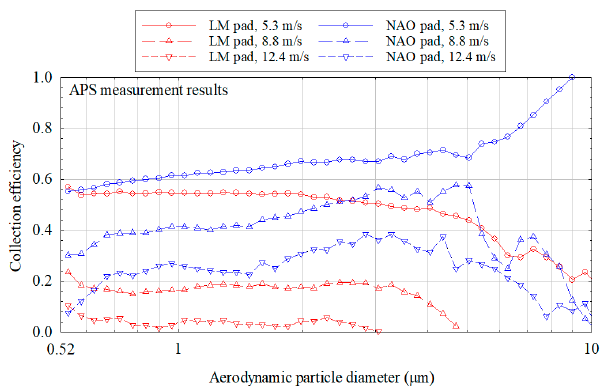
Figure 8. Size distributions of ESP collection efficiencies for various face velocities when negative 10 kV voltage was supplied.